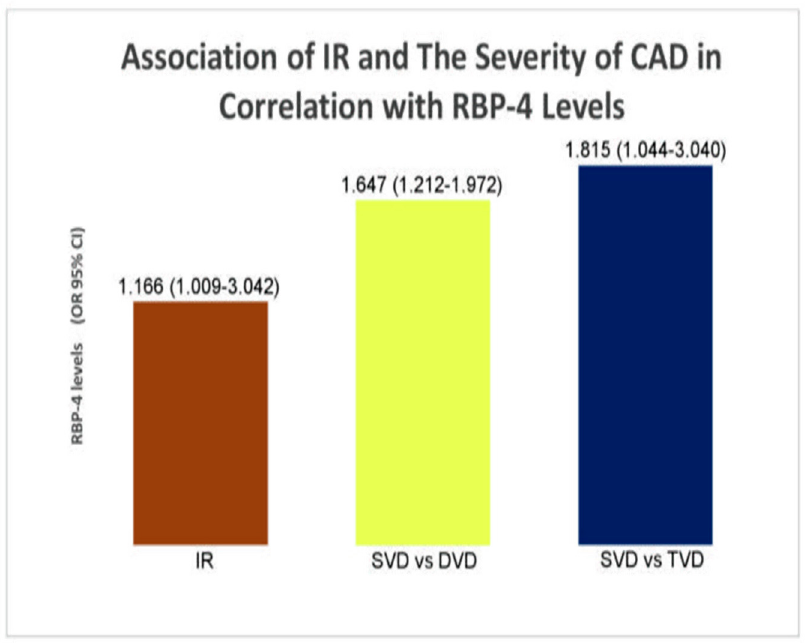
Figure 4. Association of IR and the severity of CAD in correlation with RBP-4 levels.